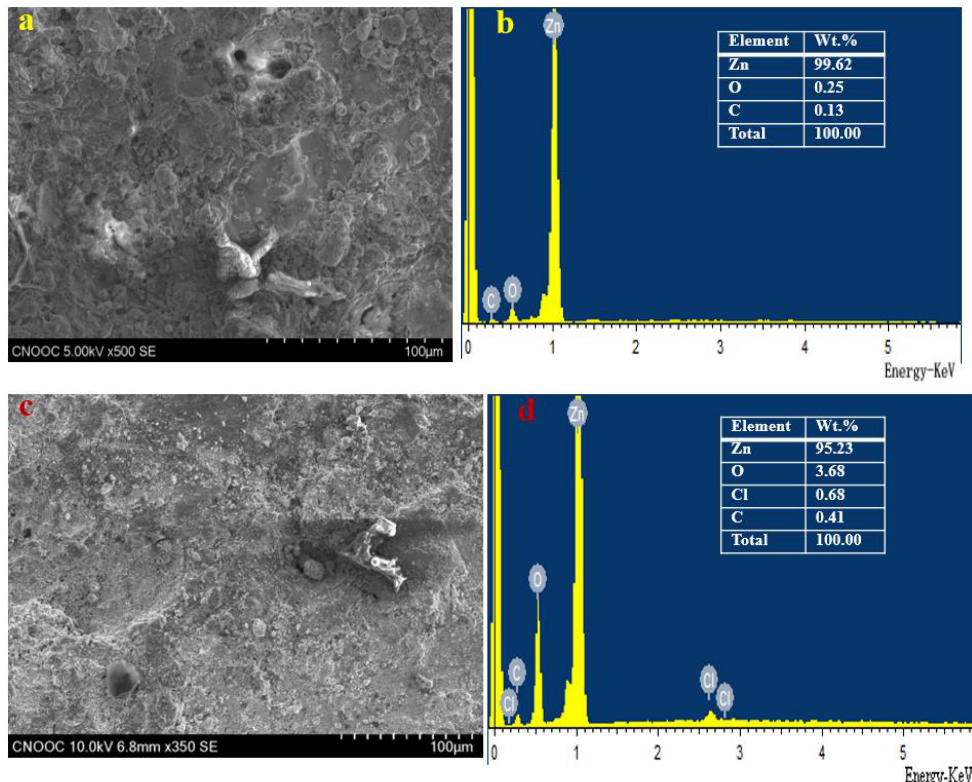
Figure 12. Analysis of the surface microstructure of the inorganic zinc-rich coating: ( a , b ) SEM pho- tograph and EDS pattern of inorganic zinc-rich coating without salt spray; ( c , d ) SEM photograph and EDS pattern of inorganic zinc-rich coating after salt spraying for 7500 h.